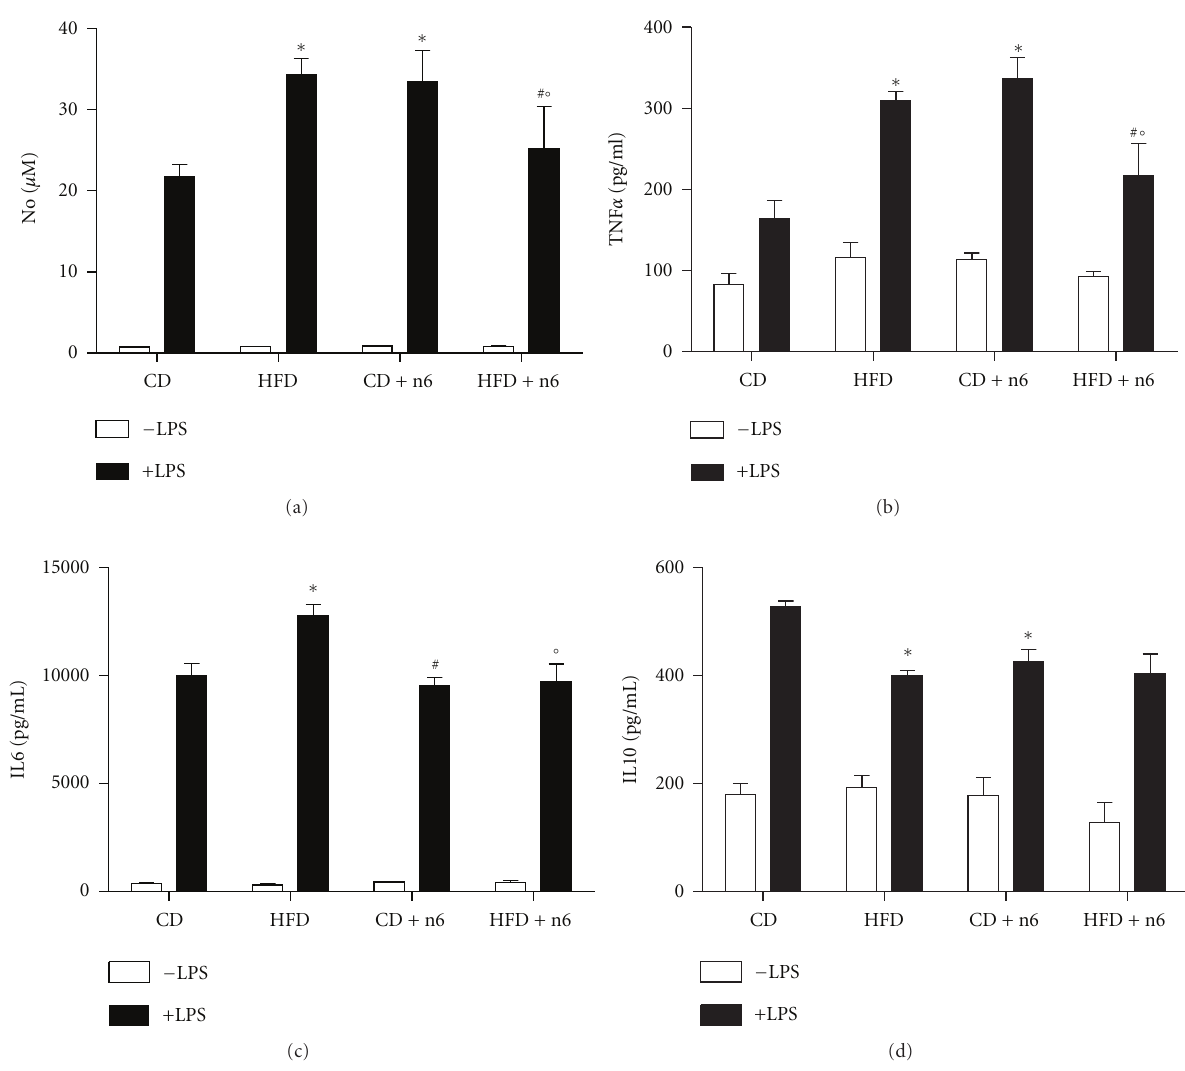
Figure 2: Nitric oxide and cytokine production in peritoneal macrophages collected from mice fed with control diet (CD) or high-fat diet (HFD), supplemented or not with sunflower oil (rich in n-6 fatty acids, 2g/Kg b.w., three times a week, by oral gavage). Animals were fed with HFD or CD for eight weeks. Peritoneal macrophages were collected and cultured for 24h in the absence (white bars) or presence (black bars) of 2.5 μ g/mL LPS. Nitric oxide (a), TNF- α (b), IL-6 (c), and IL-10 (d) were measured as described in Material and Methods. Total number of cells in peritoneal exudates was not di ff erent among the groups (data not shown). Data are presented as mean ± SEM ( n = 5–10). The CD + n6 group had just 5 samples up to the detection limit in the TNF- α assay. Two-way ANOVA and Bonferroni post-test were used for statistical analysis. All LPS stimulated conditions were di ff erent from unstimulated; ∗ P < 0 . 05 versus CD with LPS; # P < 0 . 05 versus CD + n6 with LPS; ◦ P < 0 . 05 versus HFD with